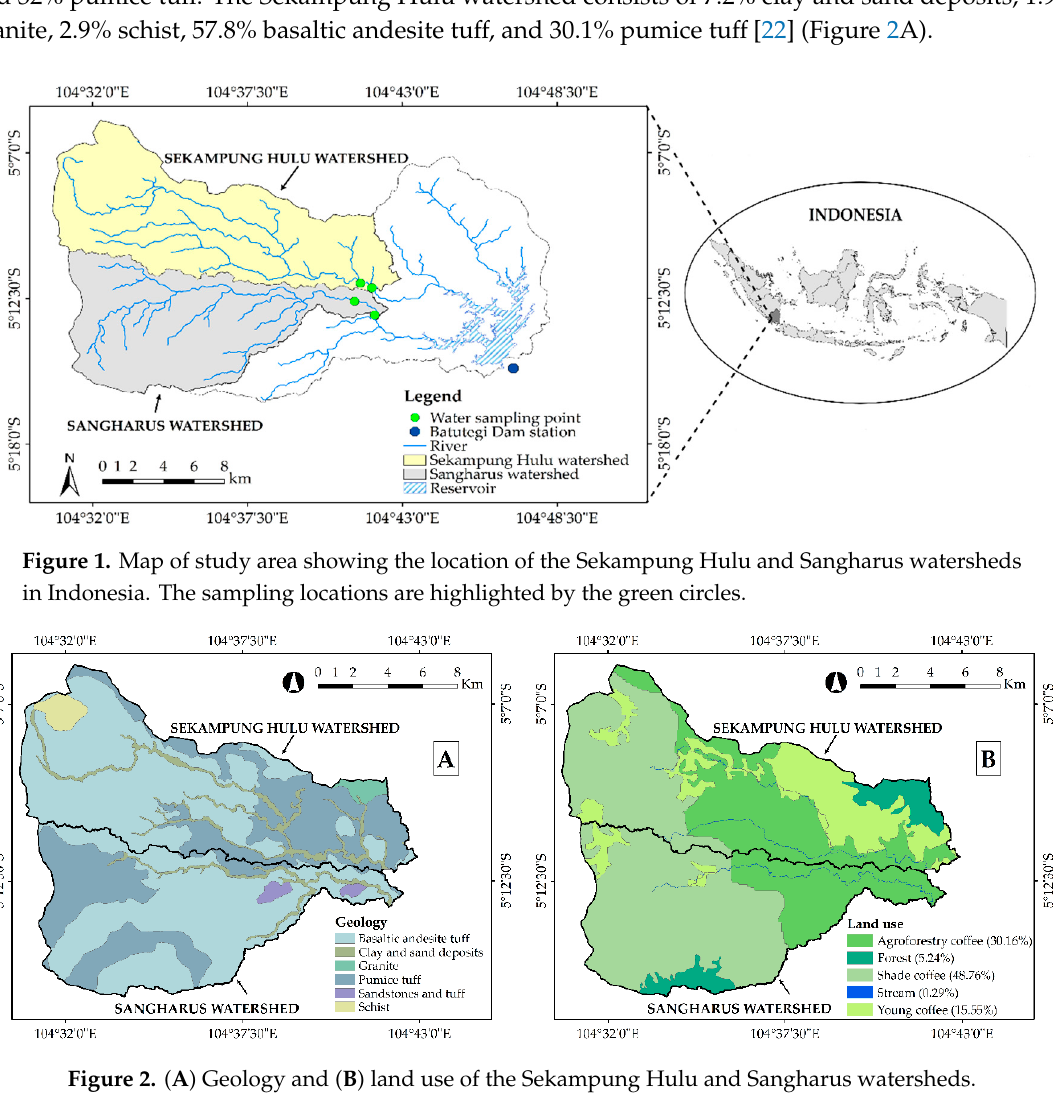
Figure 2. ( A ) Geology and ( B ) land use of the Sekampung Hulu and Sangharus